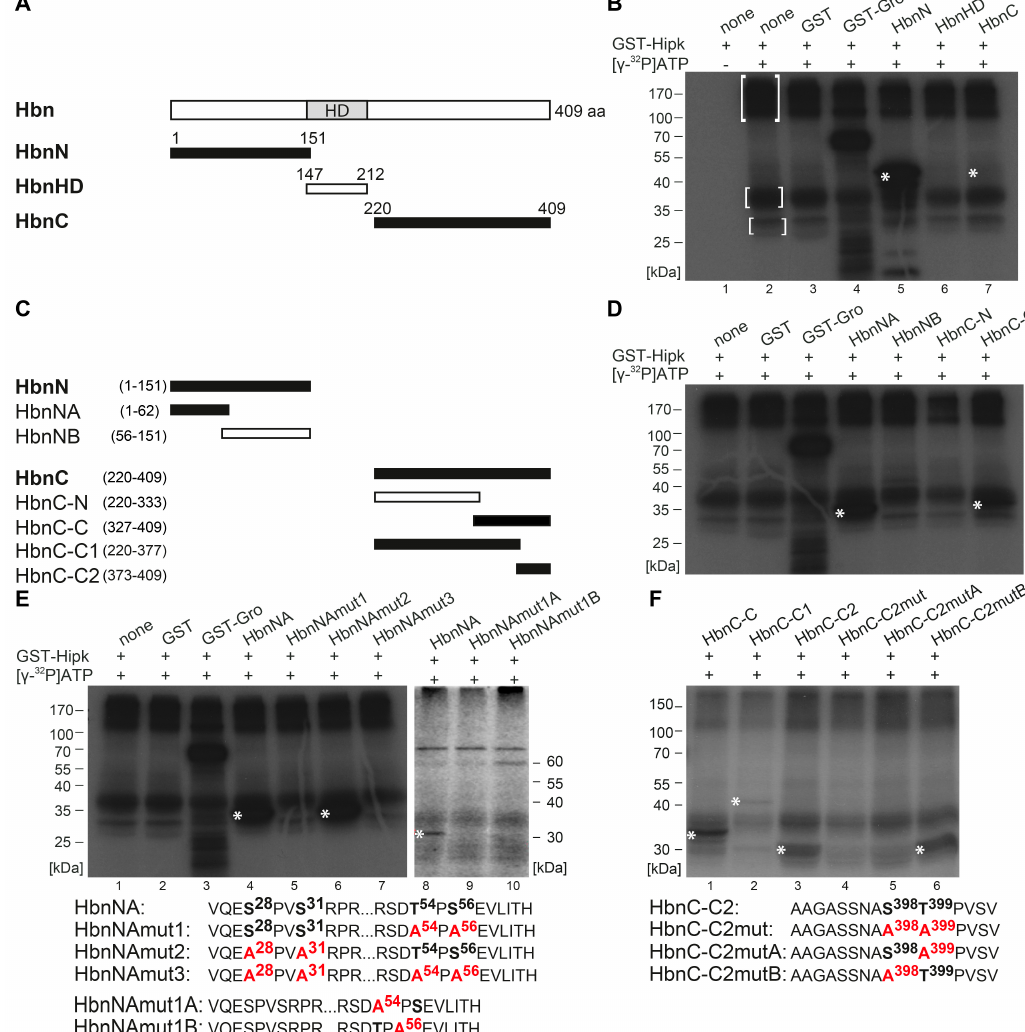
Figure 2. Hipk phosphorylates Homeobrain (Hbn). ( A ) Schematic view of the full-length protein Homeobrain (Hbn) with 409 amino acids (aa) and Homeodomain (HD), as well as the corresponding amino (N)-, homeodomain (HD)-, and carboxy (C)-terminal constructs that were purified and analyzed by phosphorylation assay. Numbers indicate terminal amino acid positions of the constructs. Phosphorylated constructs are represented in black and non-phosphorylated constructs are in white. ( B ) Autoradiograph after in vitro phosphorylation of purified proteins HbnN, HbnHD, and HbnC. Each protein contains a Glutathione S-transferase (GST)-tag and was incubated with full length GST-Hipk and radioactively labeled adenosine triphosphate ([ γ - 32 P]ATP). Glutathione S-transferase protein (GST) served as negative control and GST-Groucho (GST-Gro), a confirmed substrate of Hipk, as positive control. There is autophosphorylation of Hipk detectable (see marked within white brackets), which is to subtract from substrate phosphorylation in following lanes. Signals from phosphorylated proteins are marked with white asterisks. Loading control is shown in Figure S2. ( C ) Schematic view of the different truncated versions of HbnN and HbnC, which were generated to locate phosphorylated regions of Hbn. ( D ) Autoradiograph after in vitro phosphorylation of purified proteins HbnNA, HbnNB, HbnC-N, and HbnC-C. ( E , F ) Autoradiographs after in vitro phosphorylation of purified proteins HbnNA, HbnNAmut1, HbnNAmut2, HbnNAmut3, HbnNAmut1A, and HbnNAmut1B ( E ), as well as HbnC-C, HbnC-C1, HbnC-C2, HbnC-C2mut, HbnC-C2mutA, and HbnC-C2mutB ( F ) with the concerned amino acid sequences below, respectively. Potentially phosphorylated amino acid residues that were affected by the mutational analysis are accentuated in bold.